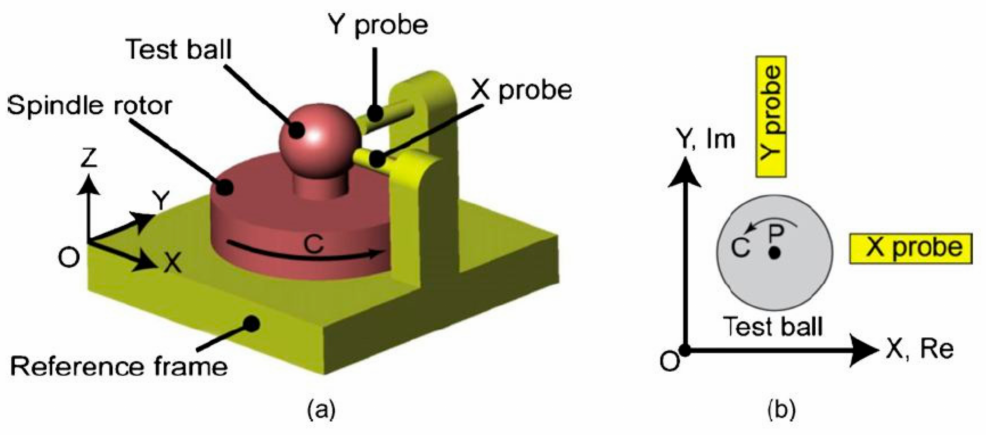
Figure 48. ( a ) Three-dimensional model of a typical setup and ( b ) view in the sensors’ axis plane